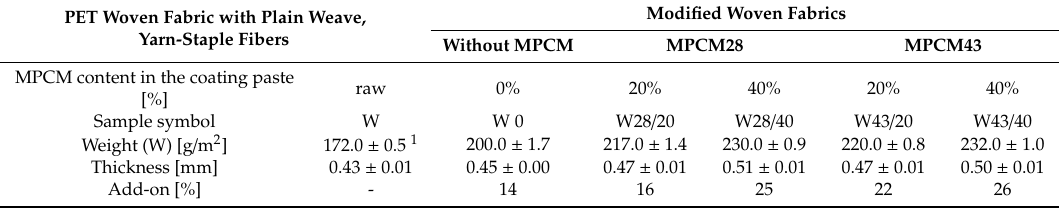
Table 4. Characteristics of woven fabrics.